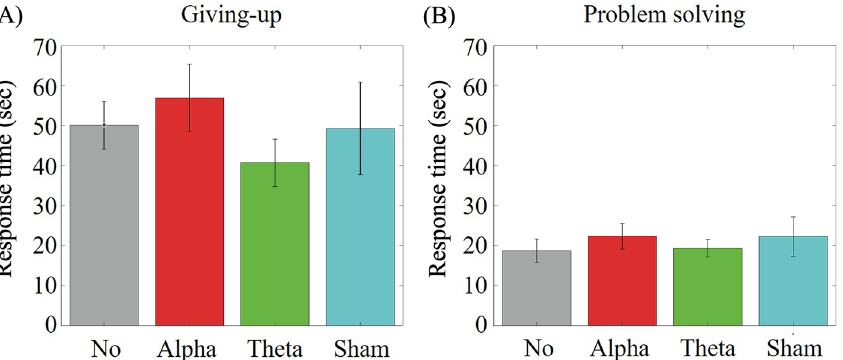
Figure 3. Modulatory effects of repetitive transcranial magnetic stimulation (rTMS) on ( A ) giving-up and ( B ) problem-solving behaviours in the rTMS condition.